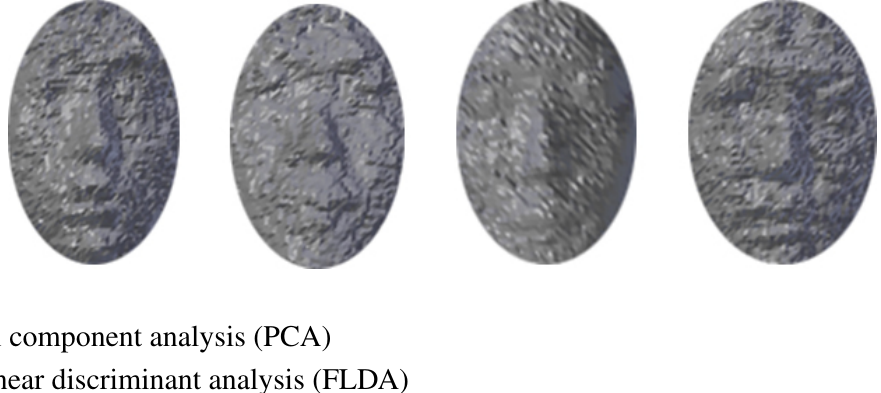
Figure 11. Samples of 3D face data acquired by the ToF